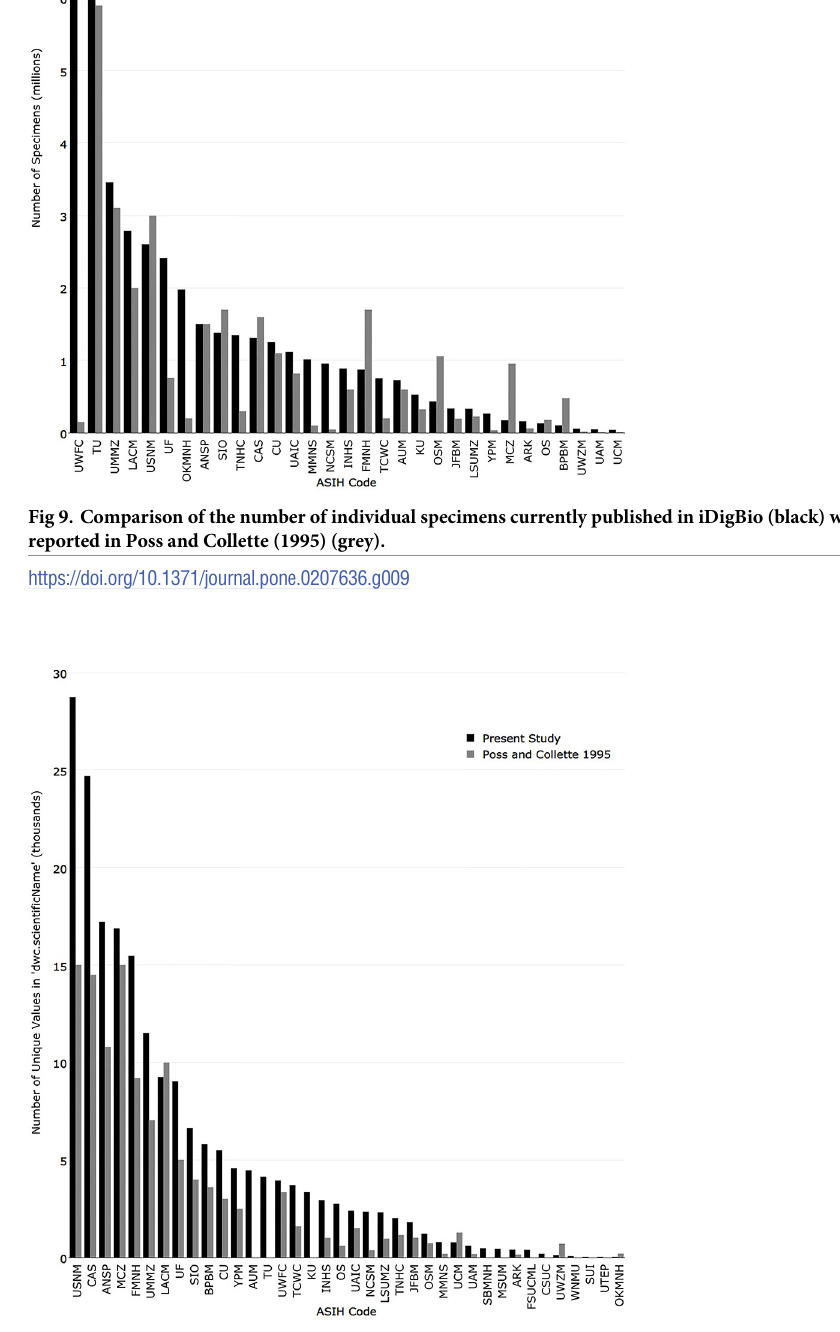
PLOS ONE | https://doi.org/10.1371/journal.pone.0207636 December19,